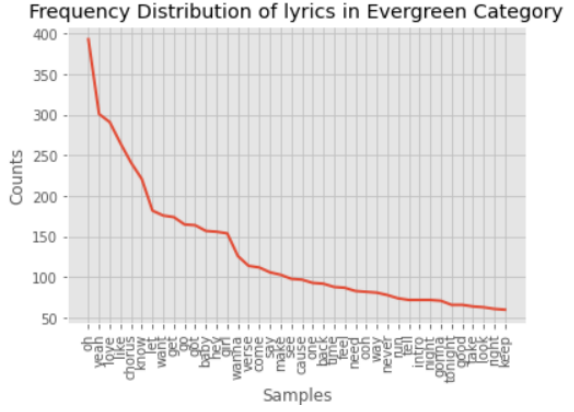
Figure 3. Frequency distribution of evergreen words used in lyrics (2009-2019)